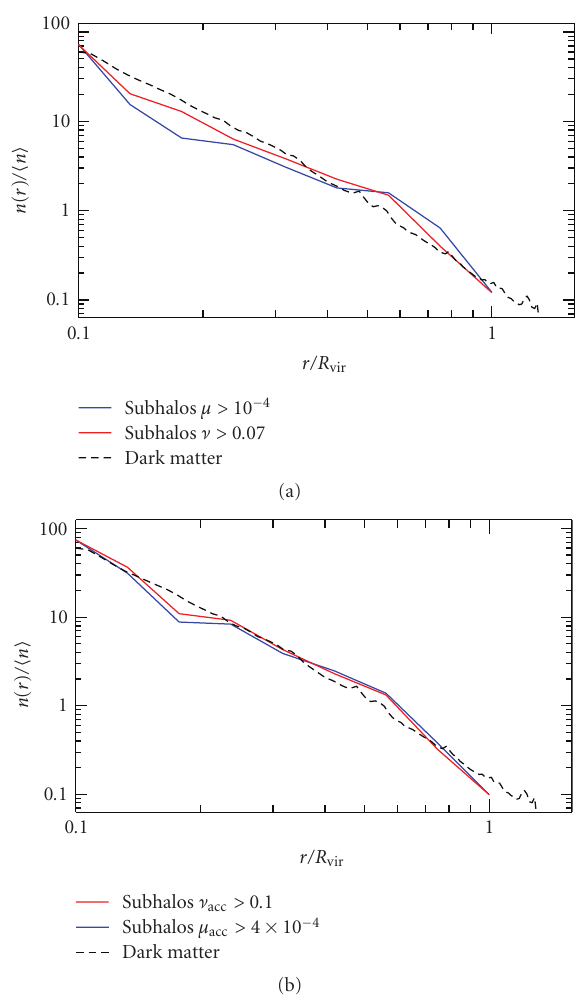
Figure 4: Radial distribution of subhalos (solid lines) selected using their di ff erent properties ( V max and total mass—solid red and blue lines, resp.) compared to the matter density profile in their host halo (dashed lines). (a) shows the profiles for subhalos selected using circular velocity and bound mass a the current epoch, while the lower shows radial distribution of subhalos selected using the corresponding quantities before subhalo was accreted una ff ected by the subsequent tidal mass loss. Note that minimum threshold values for subhalo selection, μ min and ν min , are di ff erent in (b) because for a typical mass loss many subhalos with smaller circular velocities and masses at the time of accretion fall below the completeness limit of the simulation by z =